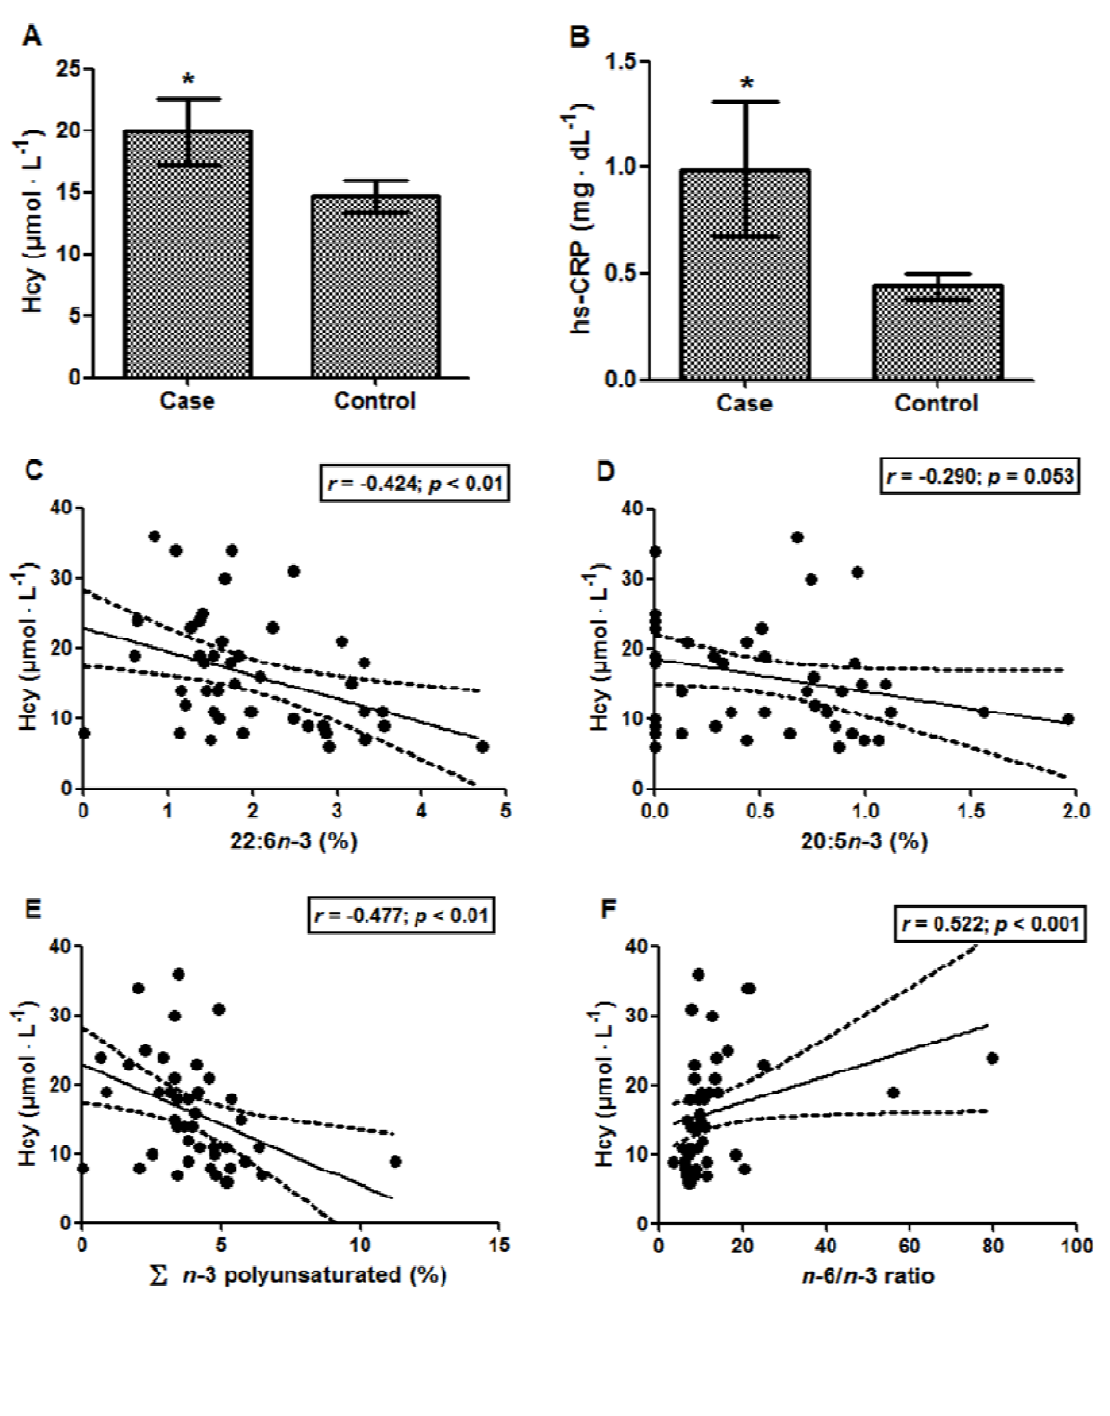
Figure 1. ( A ) Homocysteine (Hcy) and ( B ) hs-CRP levels in elderly subjects with (case) and without (control) cognitive impairment. Data are expressed as the mean ± SEM. * p < 0.05. Correlations between homocysteine vs. : ( C ) 22:6 n -3; ( D ) 20:5 n -3; ( E ) Σ n -3 polyunsaturated; and ( F ) the n -6/ n -3 ratio. In each analysis, n =